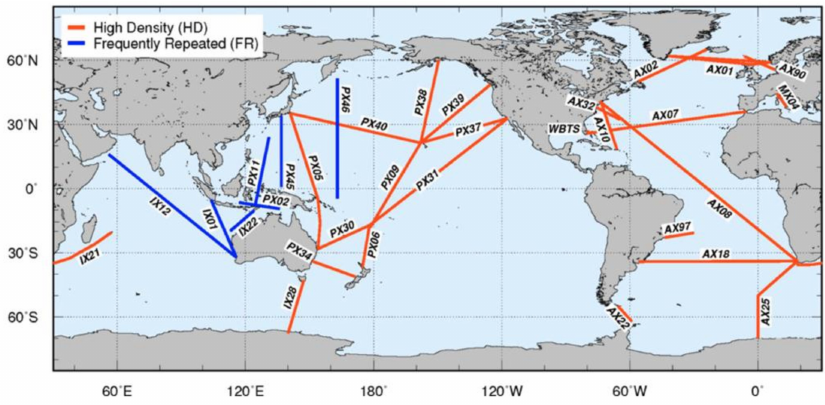
Figure 1. Location of XBT transects, as defined by the XBT Science Team